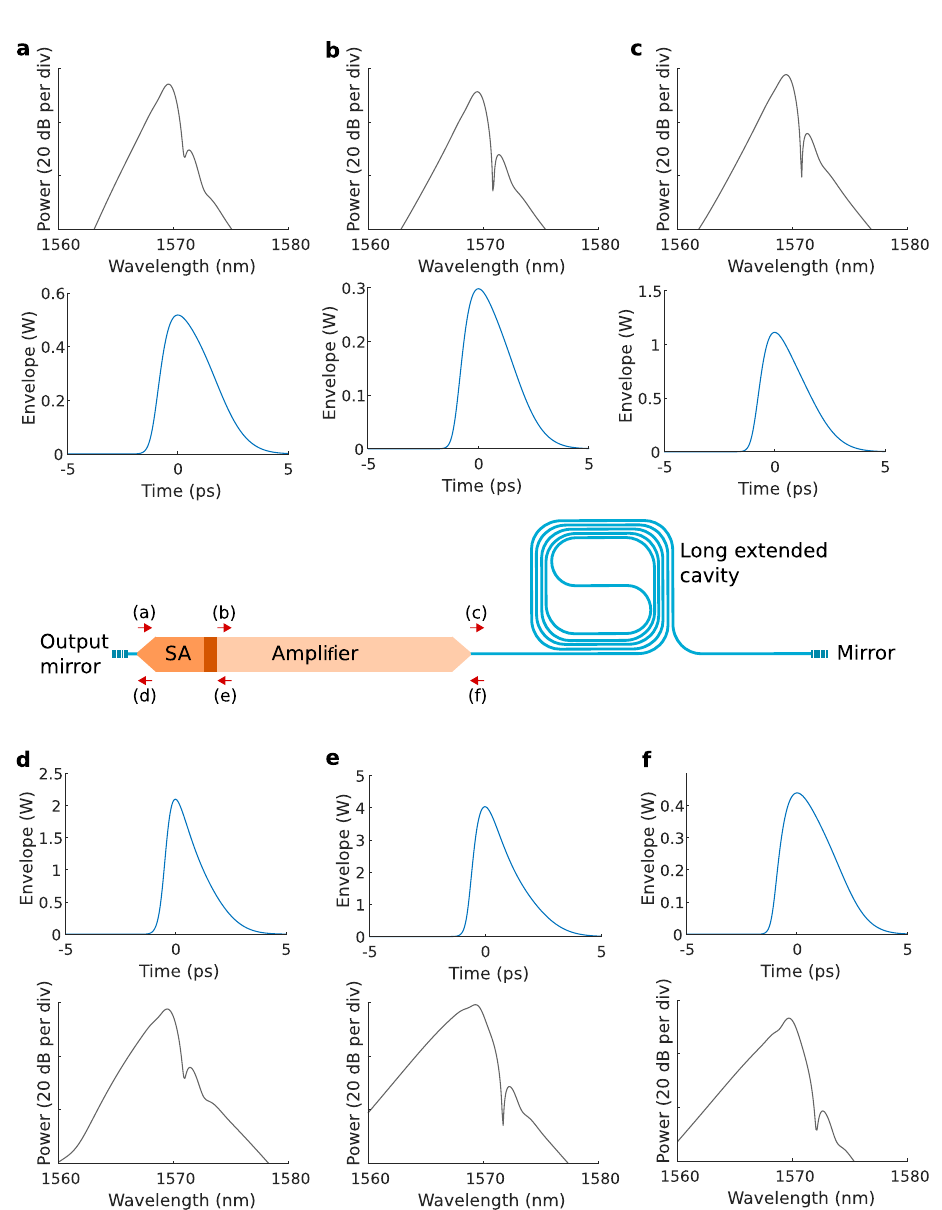
Figure 6. Temporal and spectral pulse evolution in the laser cavity. Pulse before the SA, after the spectral filter ( a ); after propagating through the SA and isolation section ( b ); before split-step Fourier propagation ( c ); after the SA, before the spectral filter and mirror ( d ); after amplification ( e ) and after propagation through the extended silicon cavity ( f